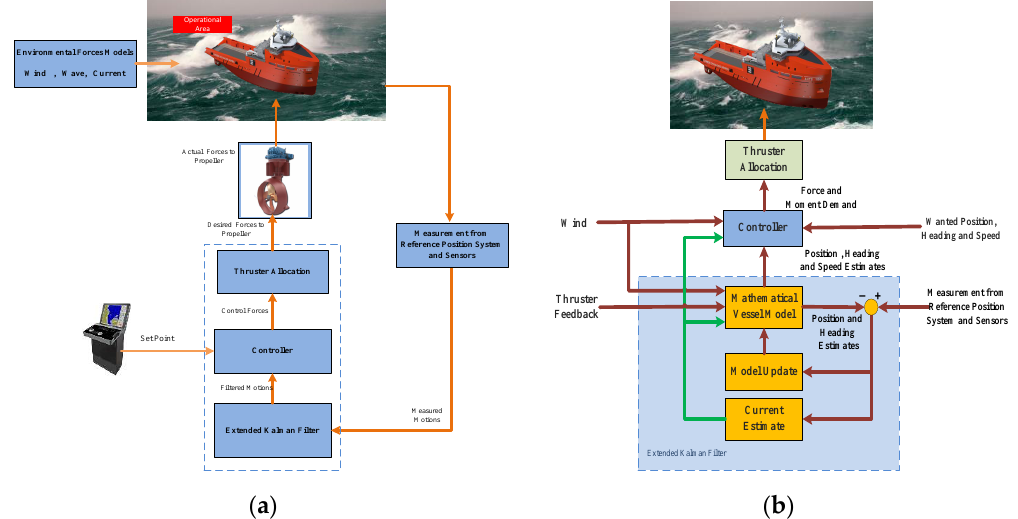
Figure 4. ( a ) A simplified block diagram of the DP control system and ( b ) the simplified block diagram of the EKF in the DPS.